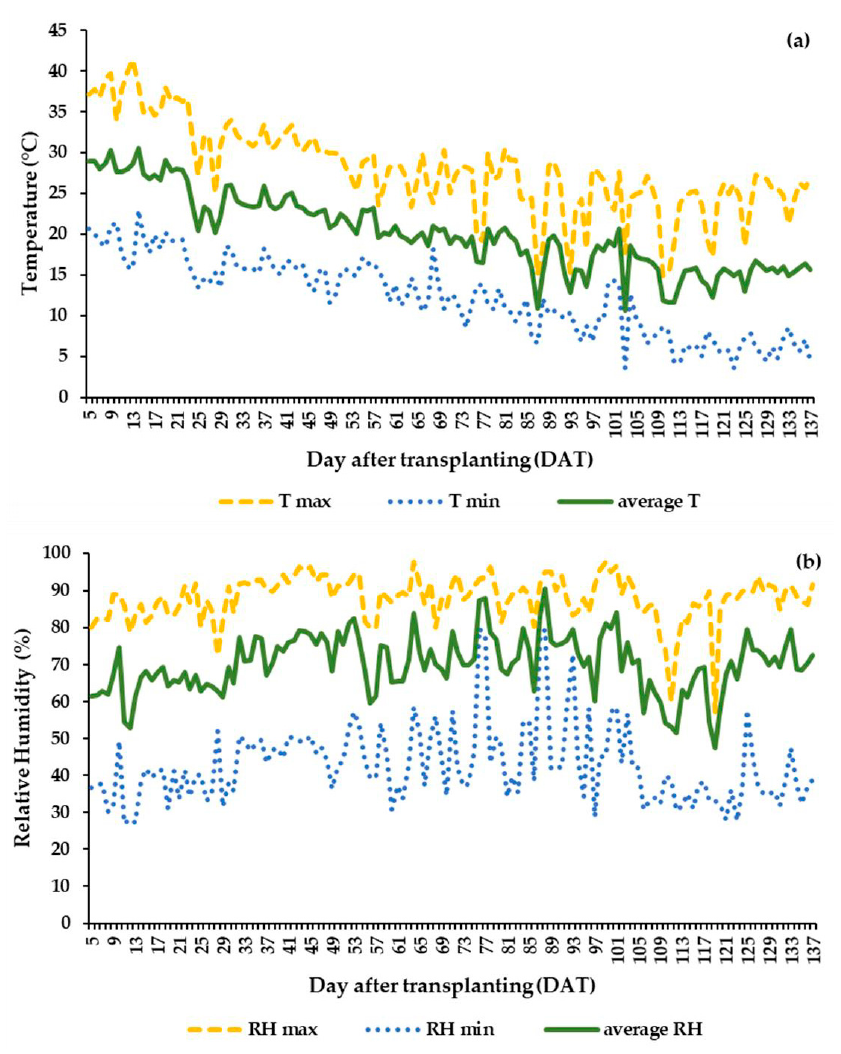
Figure 2. Maximum (T max), minimum (T min) and average (average T) daily temperature in the greenhouse during the crop cycle ( a ). Maximum (RH max), minimum (RH min) and average (average RH) daily relative humidity in the greenhouse during the crop cycle ( b ).